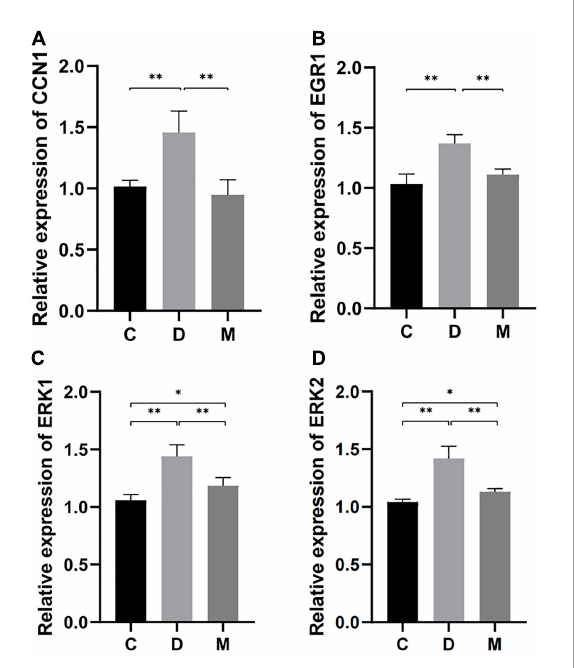
FIGURE6 Gene expression of CCN1, EGR1, ERK1, and ERK2 in ventricular cardiomyocytes from rats in C, D, and M groups. (A–D) The mRNA expression of CCN1, EGR1, ERK1, and ERK2 were decreased in rats from group M compared with C and D groups ( p < 0.01). Data are expressed as mean ± SD; ∗ p < 0.05, ∗∗ p < 0.01; C, non-diabetic control group; D, diabetic control group; M, diabetic MOTS-c injection